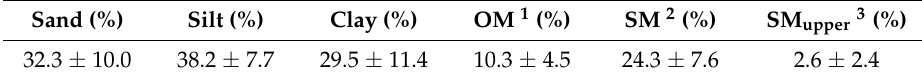
Table 11. Summary statistics (mean and standard deviation) for the measured soil properties.